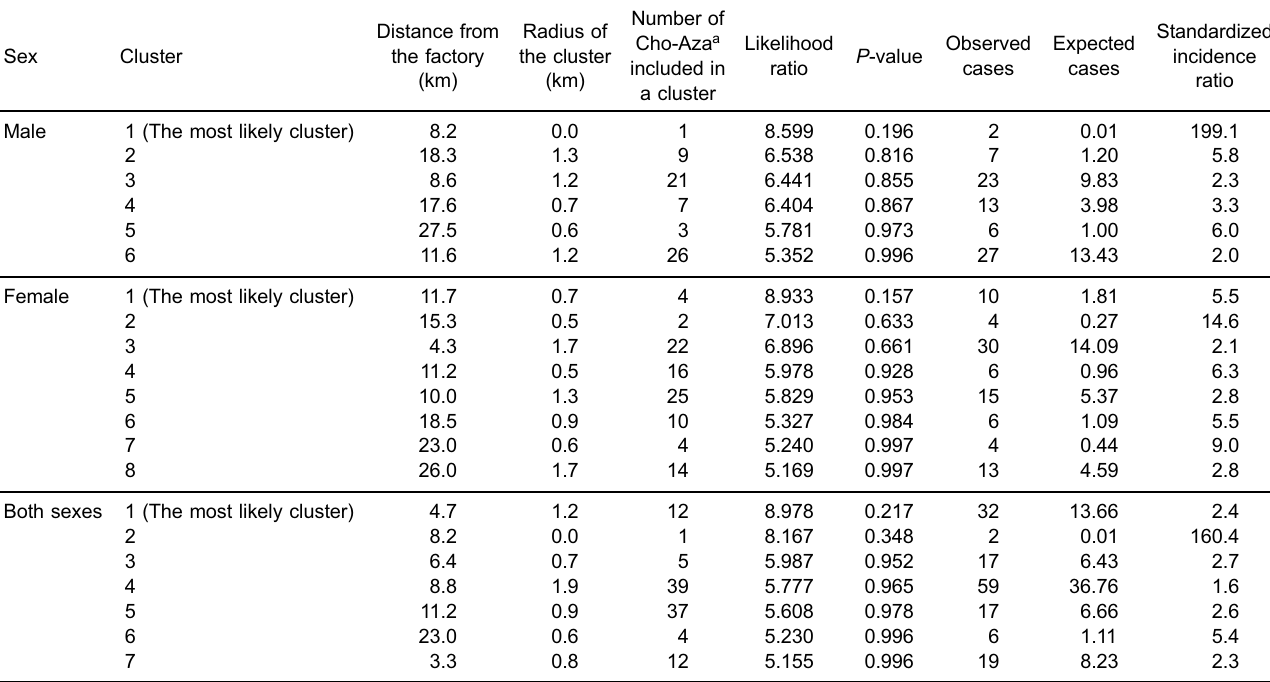
Table 1. Properties of clusters in order of smallest P -values reported by SaTScan Sex Cluster